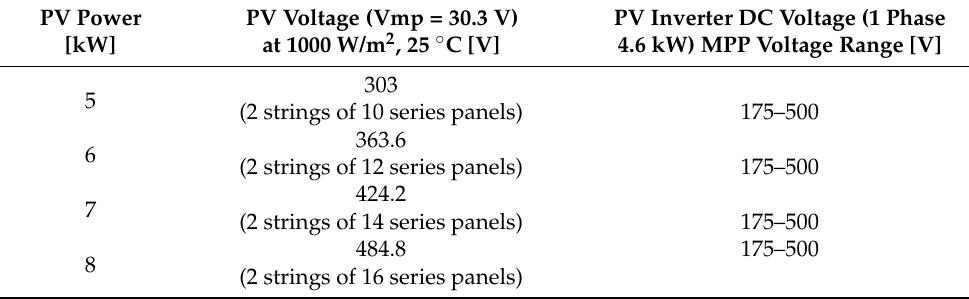
Table 1. PV modules combinations related to the inverter DC